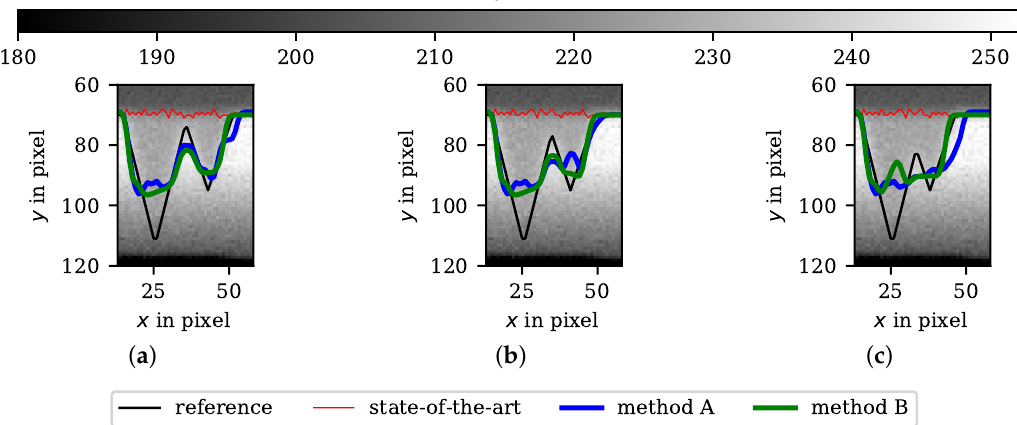
Figure 12. Evaluated flow transition line location in a simulated thermographic flow visualization with premature flow transitions along the flanks of two turbulence wedges. The position of the two turbulence wedges is varied between ( a ) not-overlapping, ( b ) medium overlapping, and ( c ) greatly overlapping. The relative contrast of all turbulence wedge is c wed = 50%. Both introduced image processing methods A (blue) and B(green) are able to cope with the overlapping of two turbulence wedges as it occurs in real